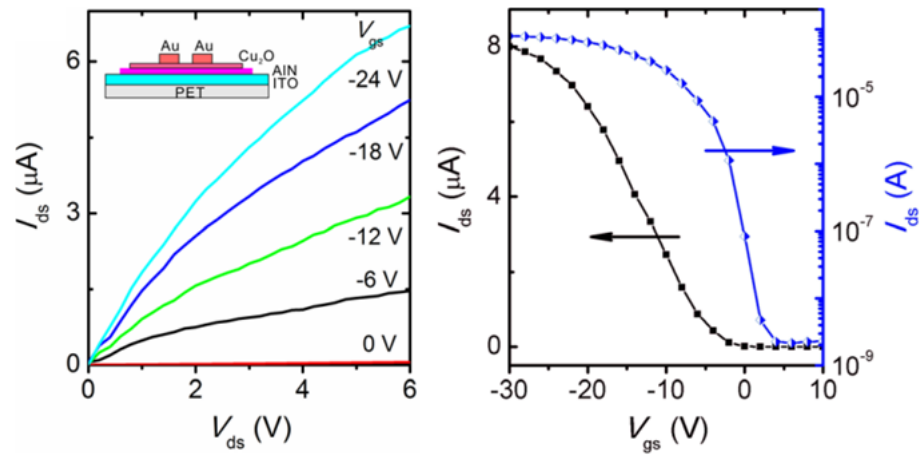
Figure 5: Characteristics of the first flexible p-type Cu 2 O TFT [52]